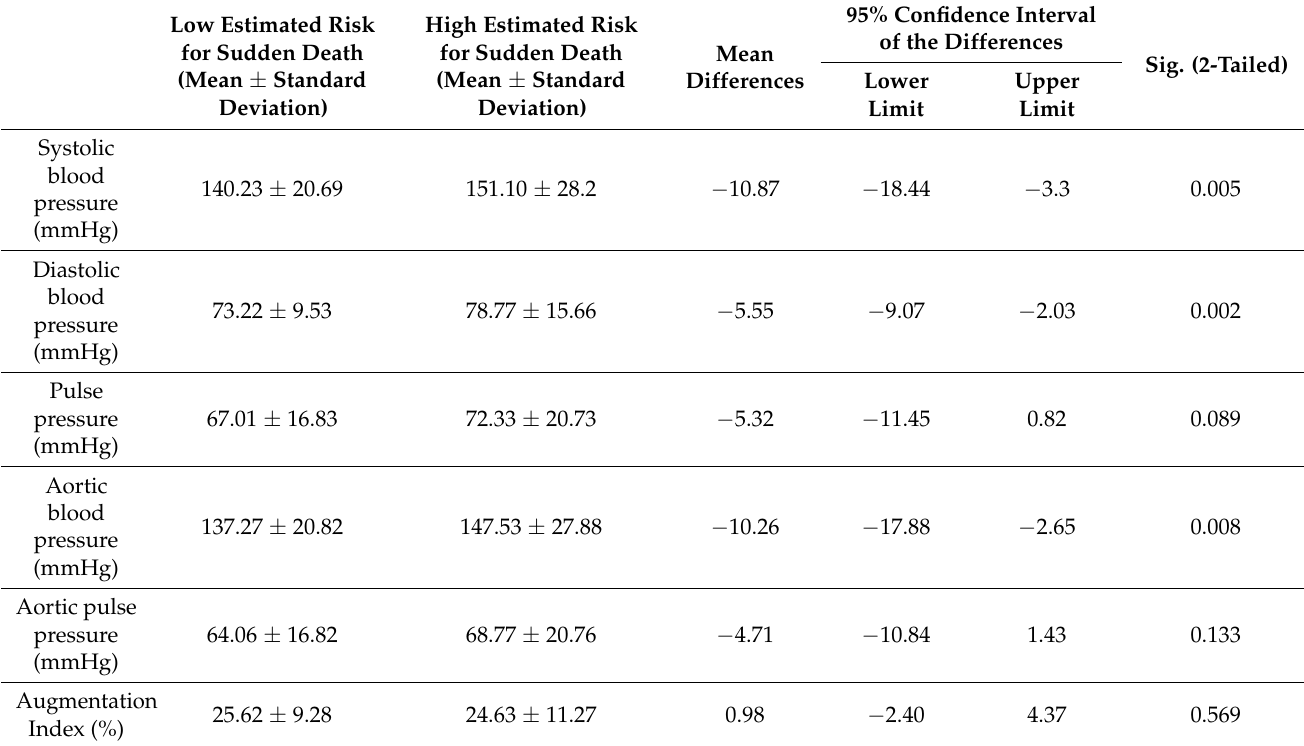
Table 4. Descriptive and comparative analysis of hemodynamic parameters laboratory parameters of the investigated